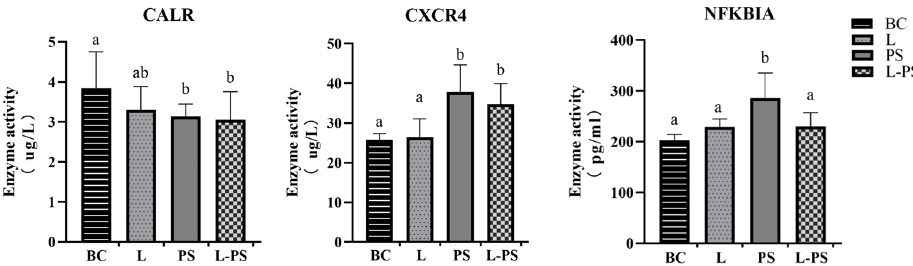
Figure 11. Protein levels of CXCR4, NFKBIA, and CALR in four groups. Different characters (a, b, c, d) show significant difference ( p < 0.05).